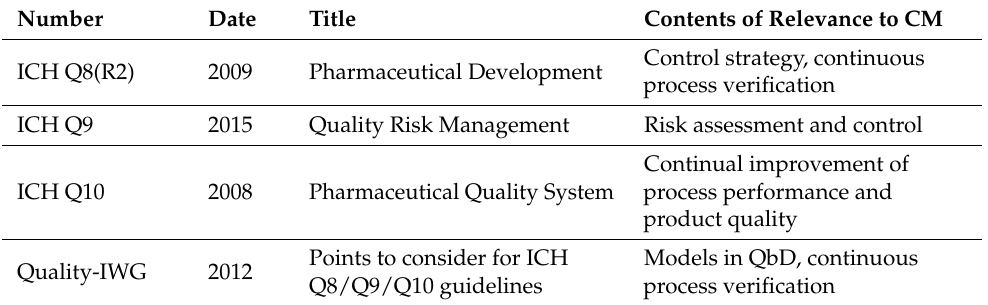
Table 4. Issued ICH guidelines of relevance to CM for a drug product, adapted from